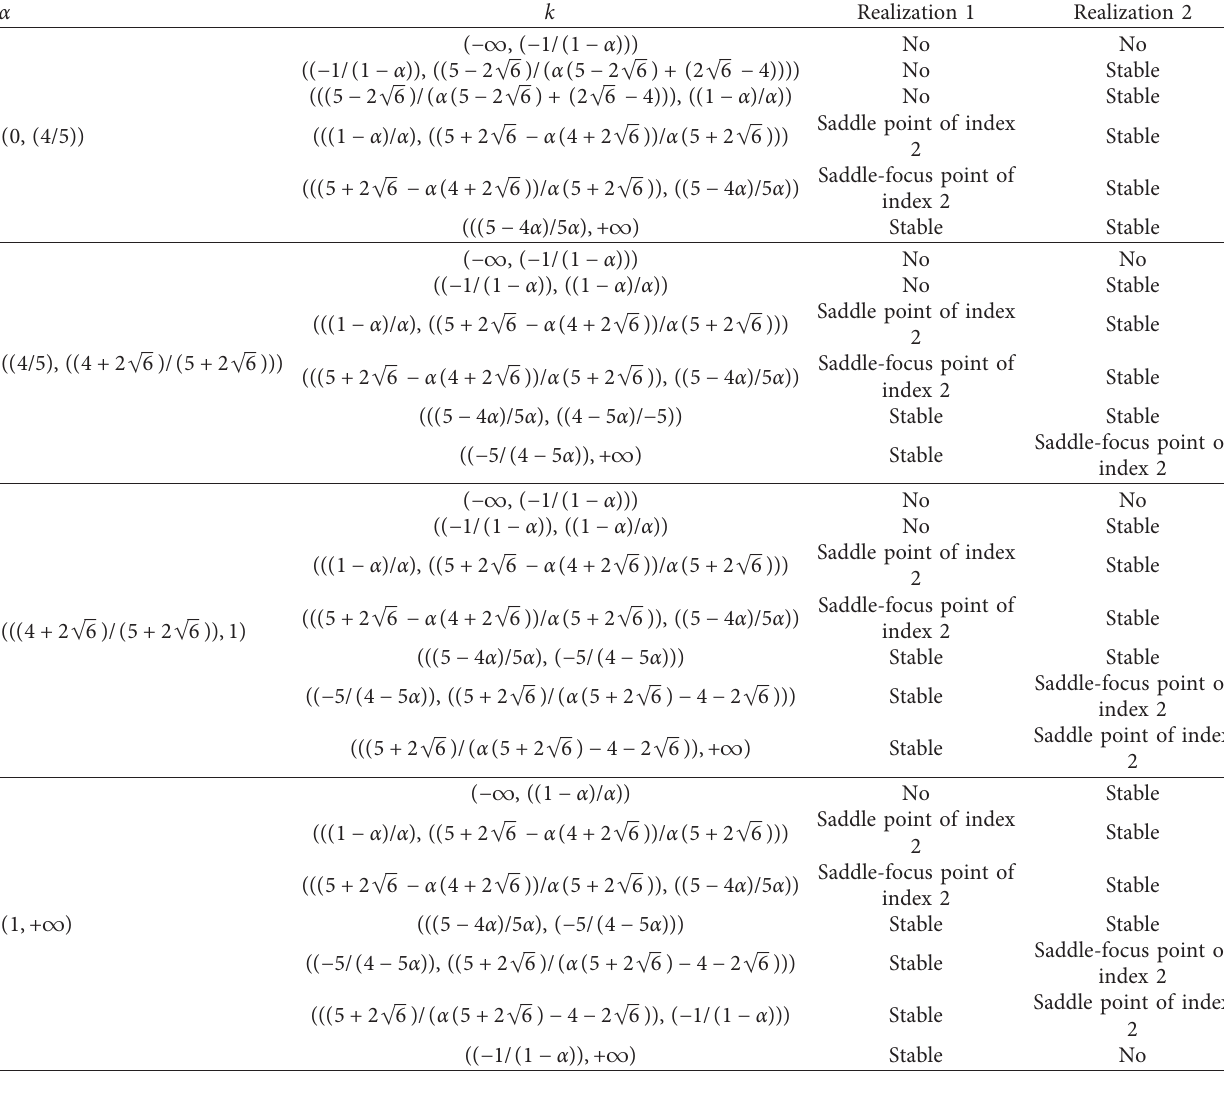
Table 3: Criterion for scenario 2 ( α is fixed and k is control